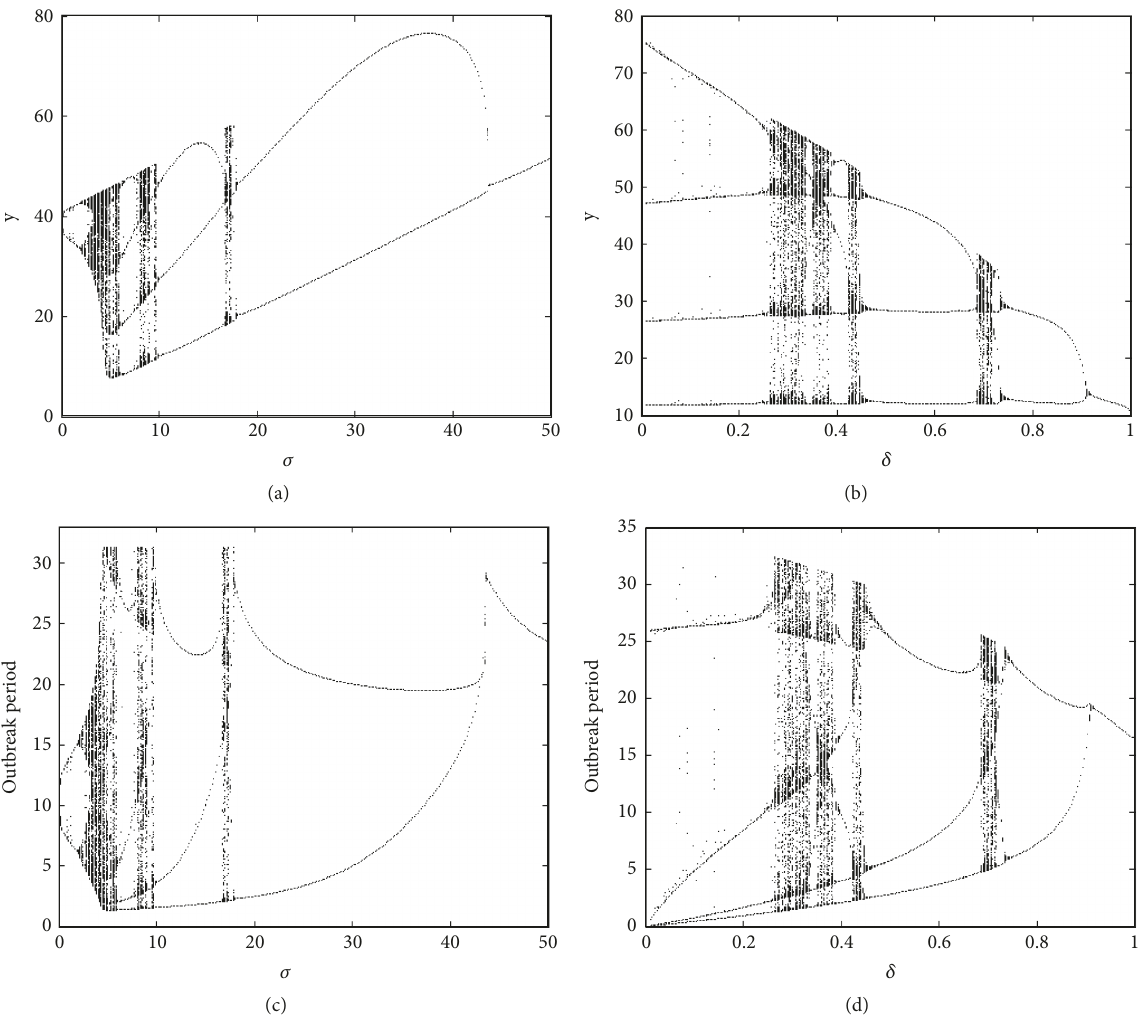
Figure 4: (a) and (c) bifurcations of system (2) for case (𝐴 1 ) with respect to control parameter 𝜎 , the parameter values were fixed as 𝑟 = 0.5 , 𝐾 = 50 , 𝑚 = 0.15 , 𝐴 = 0.5 , 𝑠 = 0.043 , ℎ = 1.25 , 𝐸𝑇 = 20 , 𝛿 = 0.3 , and 𝑞 = 0.4 ; (b) and (d) bifurcations of system (2) for case (𝐴 to 𝛿 when 𝑟 = 0.5 , 𝐾 = 60 , 𝑚 = 0.15 , 𝐴 = 0.5 , 𝑠 = 0.05 , ℎ = 1.333 , 𝐸𝑇 = 25 , 𝜎 = 10 , and 𝑞 = 0.4